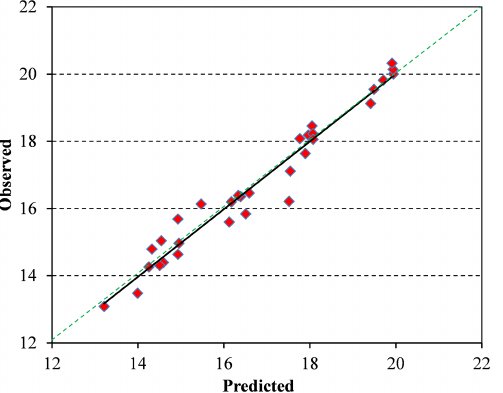
Figure 6. Observed and predicted SS flux (kgyr − 1 ) at 31 monitor- ing sites included in the Ishikari SPARROW model (Natural loga- rithm transformation applied to observed and predicted values; the black line is the trend line, the green dashed line is a 1:1 line).